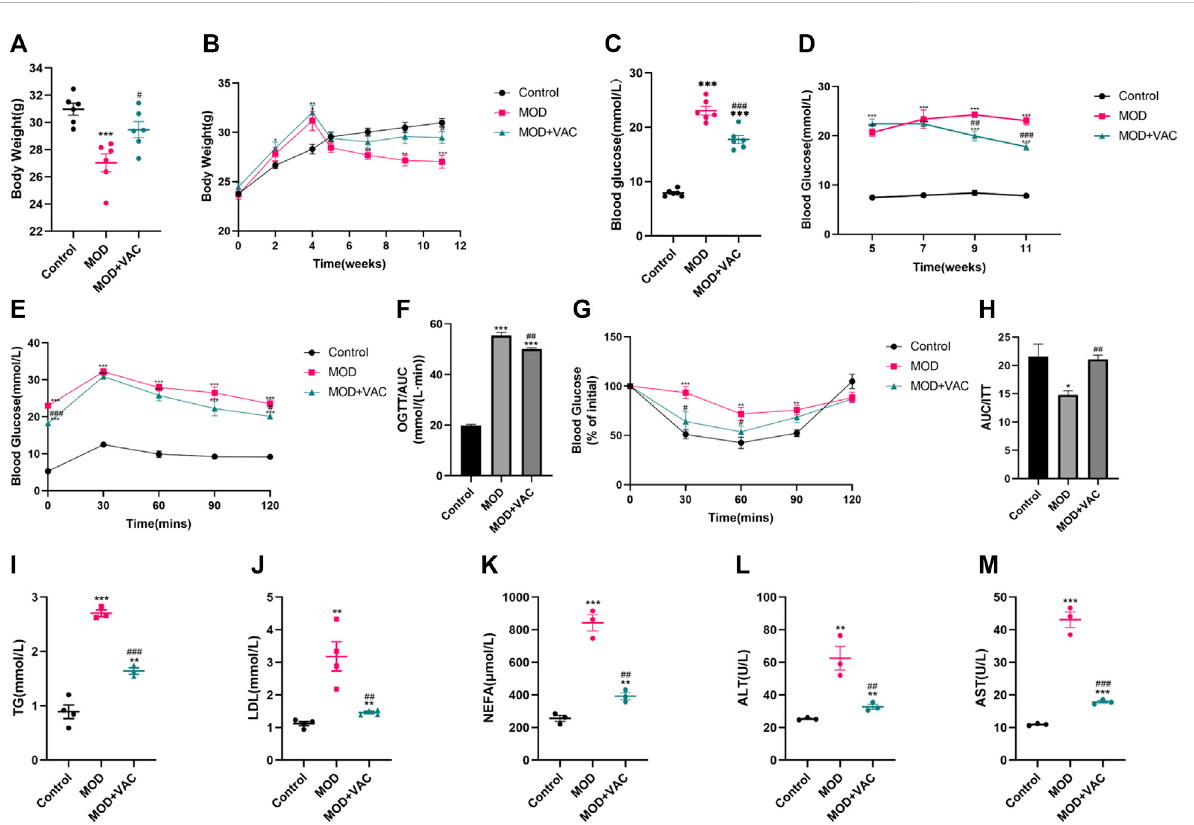
FIGURE 2 Vaccarin can signi fi cantly improve the physiological state and blood glucose level of T2DM mice. (A) . The weight of the mice at the terminal of the experiment. (The fi rst 5 weeks were the modeling period and the last 6 weeks were the administration period.) (B) . Weekly weight changes after thestartoftheexperiment. (C) .Fastingbloodglucose.After6weeksoftreatment,fastingbloodglucose wastested inthemice. (D) .Weeklychanges of fasting blood glucose after successful modeling. (E) . Oral glucose tolerance test (OGTT). (F) . Area under the curve (AUC) level of OGTT. (G)